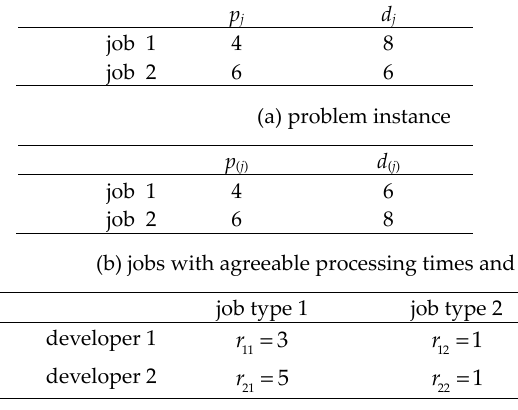
Figure 2. An anomaly.